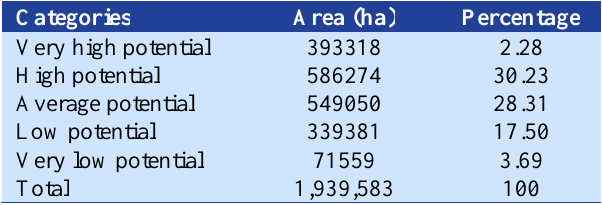
Table 2. Classification of areas based on ecological potential